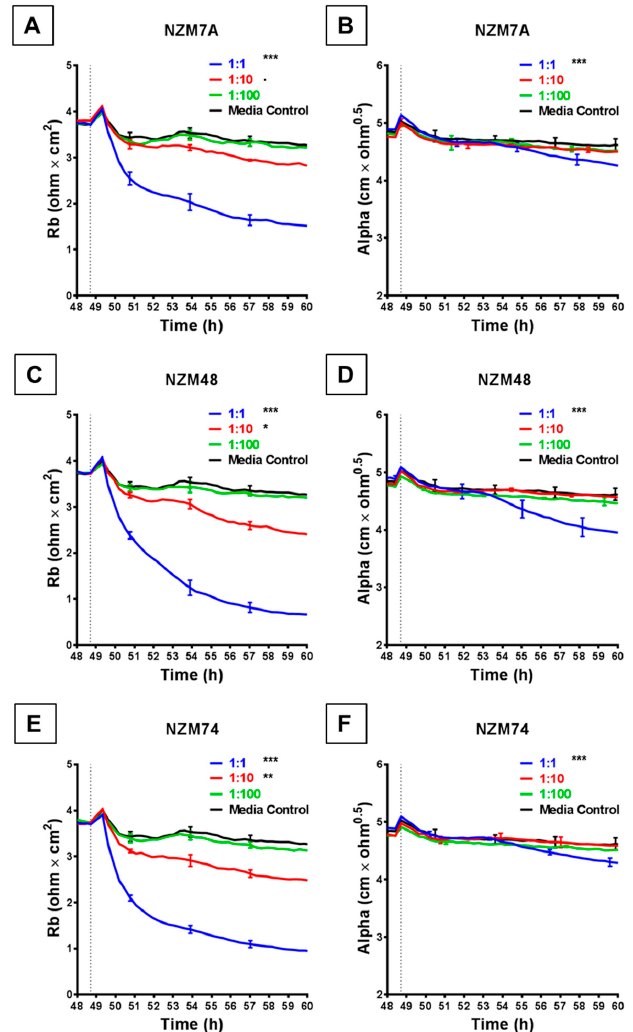
Figure 3. ECIS reveals decreases in hCMVEC paracellular and basolateral resistance following exposure to melanoma cells NZM7, 48 and 74. ( A ), ( C ), ( E ) Modelled paracellular resistance (Rb) of hCMVECs over time after addition of NZM cell lines. ( B ), ( D ), ( F ) Modelled basolateral resistance (Alpha) of hCMVECs over time after addition of NZM cell lines. NZM cells were added at 48 h (dotted line). Data shown as mean ± SD ( n = 3 wells) from a single experiment; endpoints from three independent experiments were compared relative to their media control using two-way ANOVA with Tukey’s range test ( . p < 0.1, * p < 0.05, ** p < 0.01, *** p < 0.001). Each melanoma line also decreased the basolateral resistance at an ET ratio of 1:1 but not at the lower ET ratios. An important observation from the modelled data demonstrates that for these lines, the Alpha parameter (focal adhesion) did not change substantially for at least 2 or 3 h after melanoma addition (Figure 3B,D,F). This is important, as it indicates that the predominant and earliest change to the overall resistance is due to changes in the paracellular resistance and that the melanoma cells affect the paracellular barrier first, followed by the focal adhesion, which is what would be expected during paracellular migration.